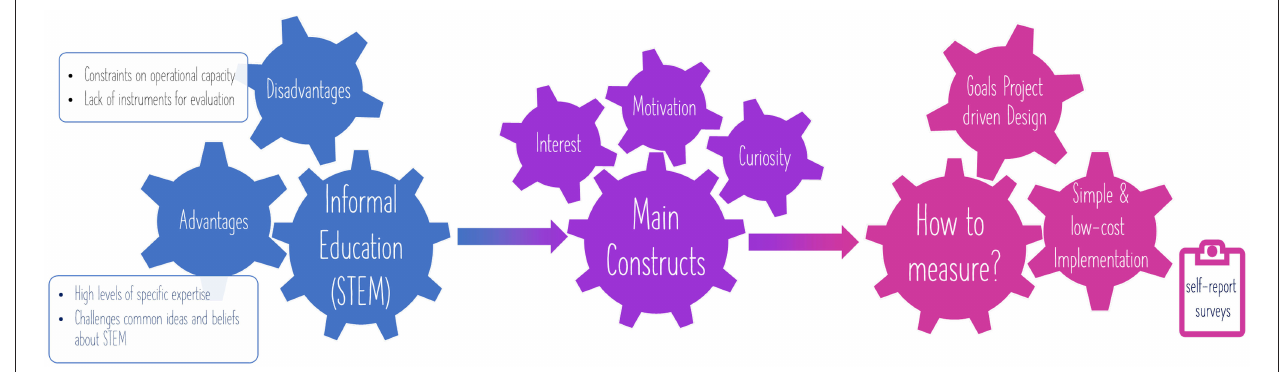
FIGURE 1 | Advantages and disadvantages faced in STEM informal education, main constructs to measure and some hints about the